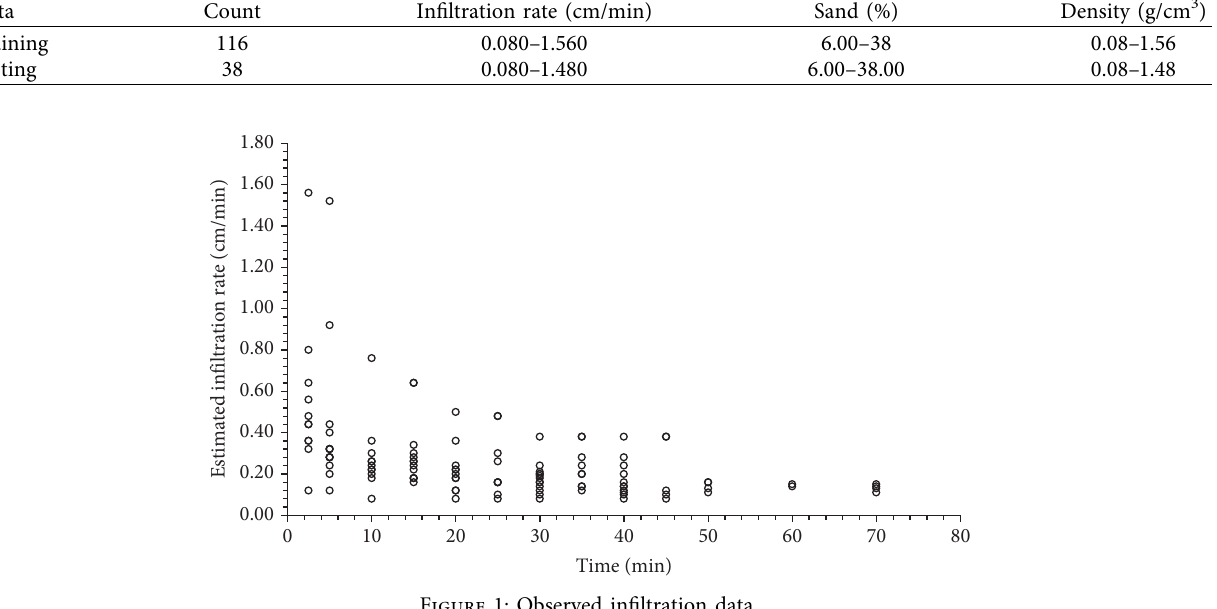
Figure 1: Observed infiltration